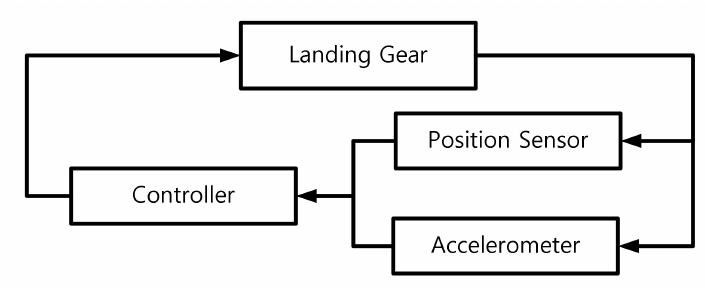
Figure 9. Control scheme in practical operation